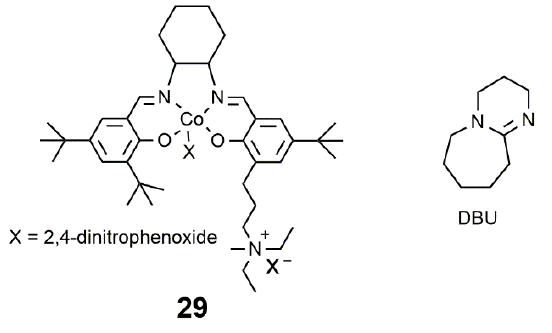
Figure 11. Complex 29 and organocatalyst DBU